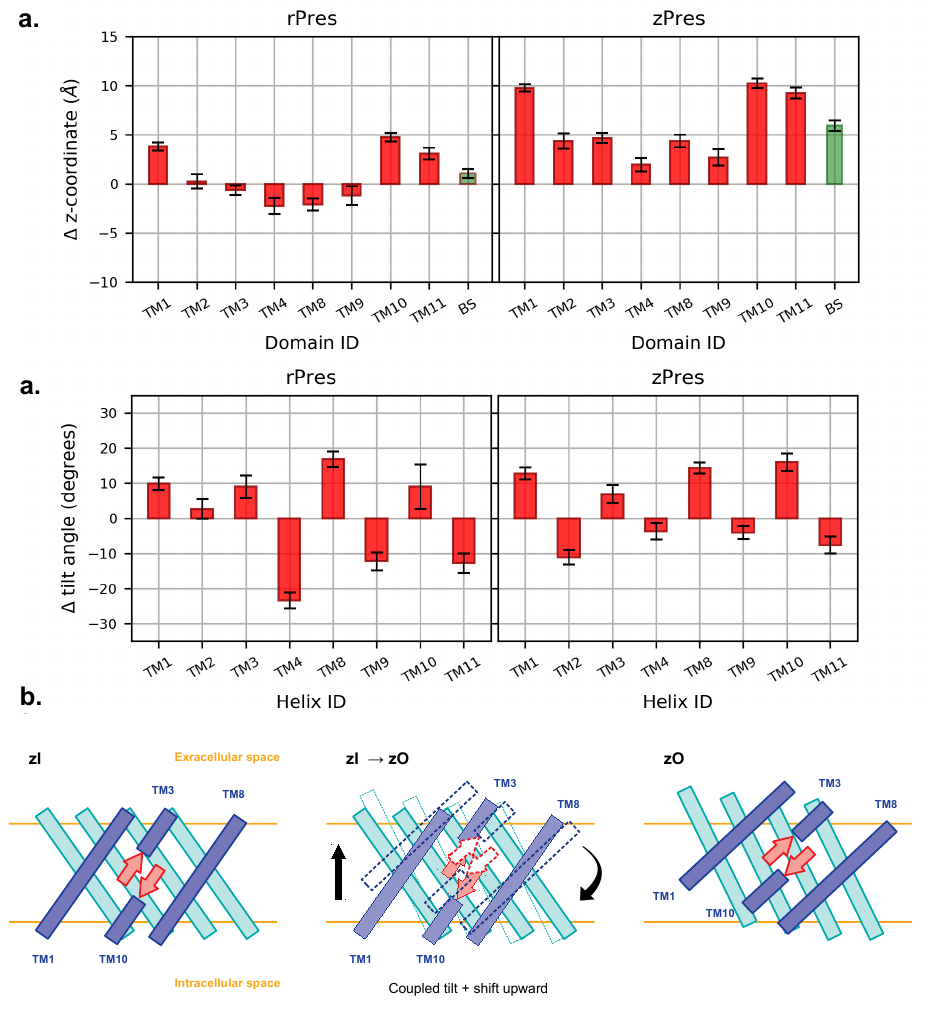
Figure 5. ( a ) Average shift along the z -axis of the center of mass of each core TM in the outward state (O), with respect to the most representative inward conformation (I), after structural alignment of the gate. BS indicates the β -sheet. A positive value indicate an upward movement of the center of mass when going from I to O. ( b ) Average difference in the tilt angle of the core TMs, computed comparing each frame of the O simulations and the representative I structures. The tilt angle is taken as the angle between the helix axis and the z -axis. ( c ) Relative disposition of the core TMs belonging to the inner shell (blue) and outer shell (cyan) and of the β -sheet forming the binding cavity (red), in zI and zO conformations. The latter is the result of a shift and a tilt, which together preserve the secondary structure of the β -sheet and lift it towards the extracellular